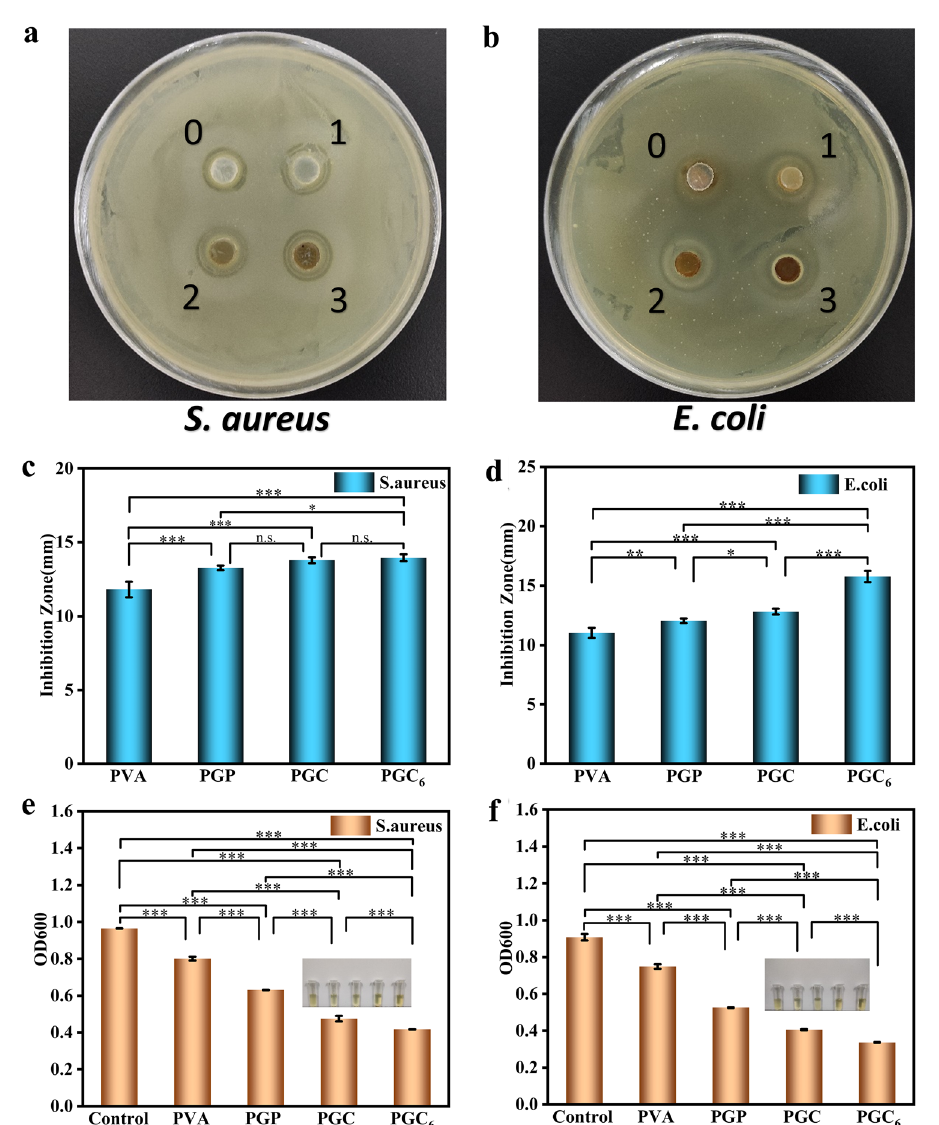
Fig. 4 Antibacterial activity of PVA, PGP, PGC and PGC 6 against a S. aureus , b E. coli . The diameter of inhibition circle of different hydrogels: c S. aureus , d E. coli ( n = 5). The OD data of e S. aureus , f E. coli , the photographs in the figure are their corresponding bacterial suspension after 24 h incubation ( n = 3). (* p ≤ 0.05, ** p ≤ 0.01, *** p ≤ 0.001, n.s.: no significant